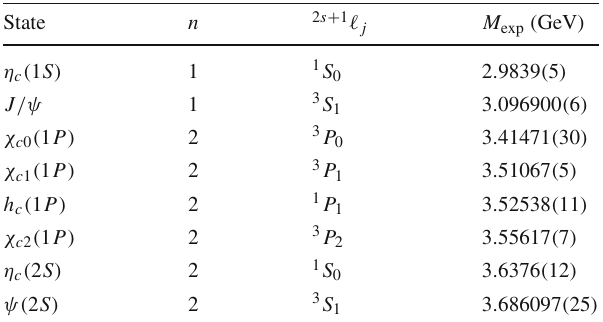
Fig. 4 Comparison of the Cornell Model (blue) and QCD (green) pre- dictions to experimental bottomonium data (red). Both QCD and the Cornell model have been fitted to the same experimental data with n p ≤ 2. QCD error bars correspond to perturbative uncertainties, while the Cornell-Model uncertainties come only from the fit Table 2 Experimental masses of the charmonium states, up to n = 2. Data from Ref.